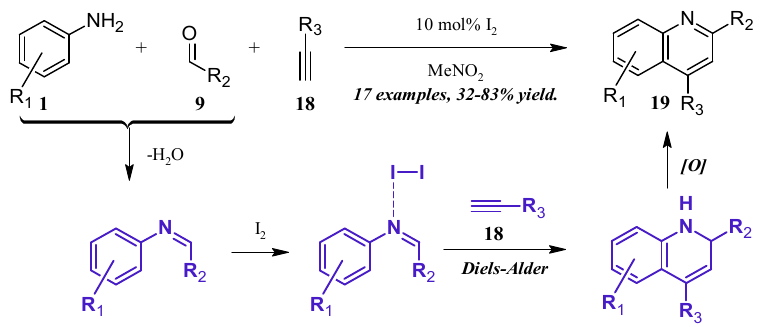
Figure 11. Iodine-catalyzed multicomponent Povarov reaction.